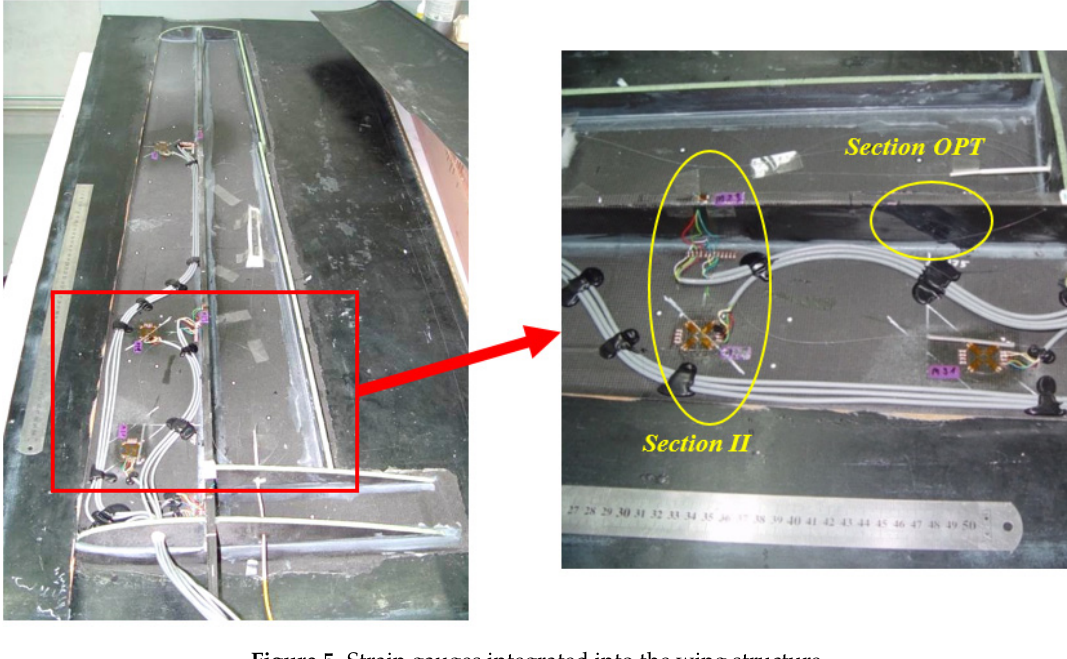
Figure 4. Strain gauges positions inside the wing structure (dimensions in mm).